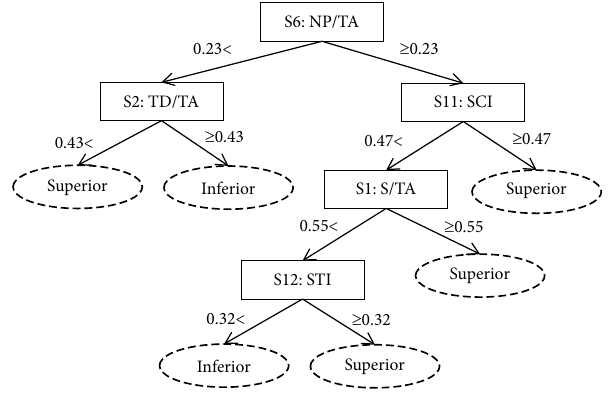
Figure 8. The decision